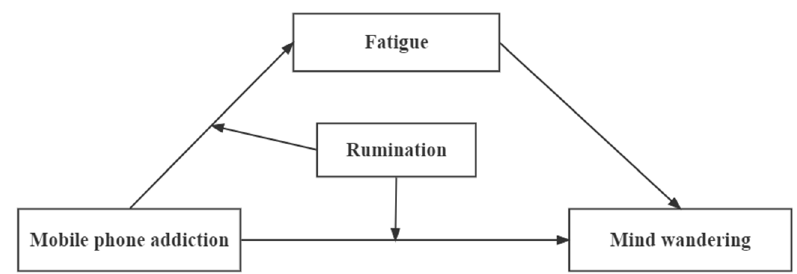
Figure 1. Hypothetical model for this study.